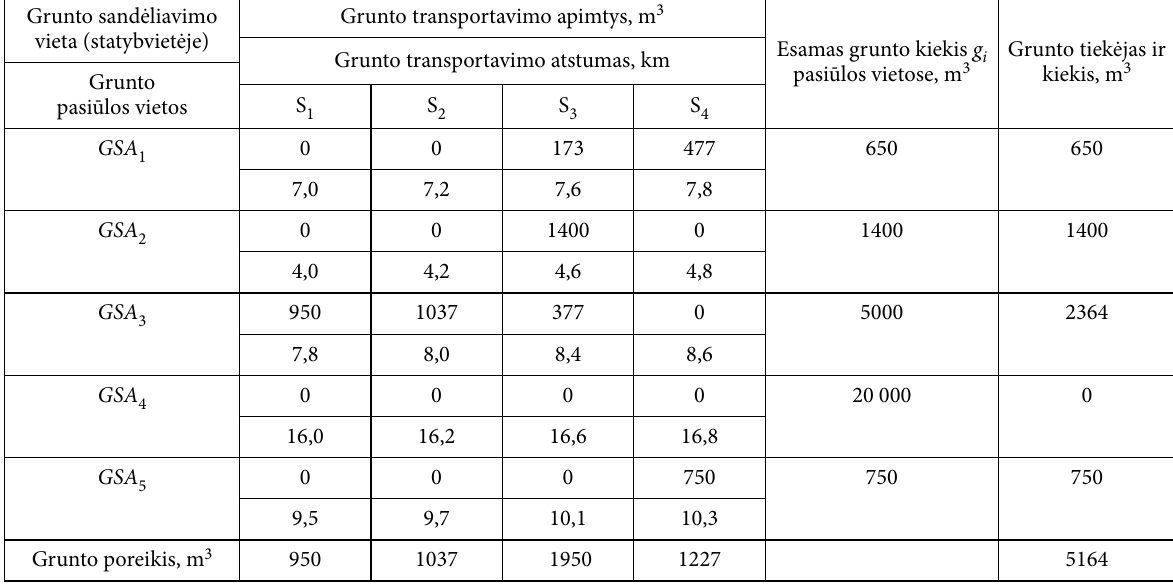
Table 4. A rational plan for soil supply Grunto transportavimo apimtys, m